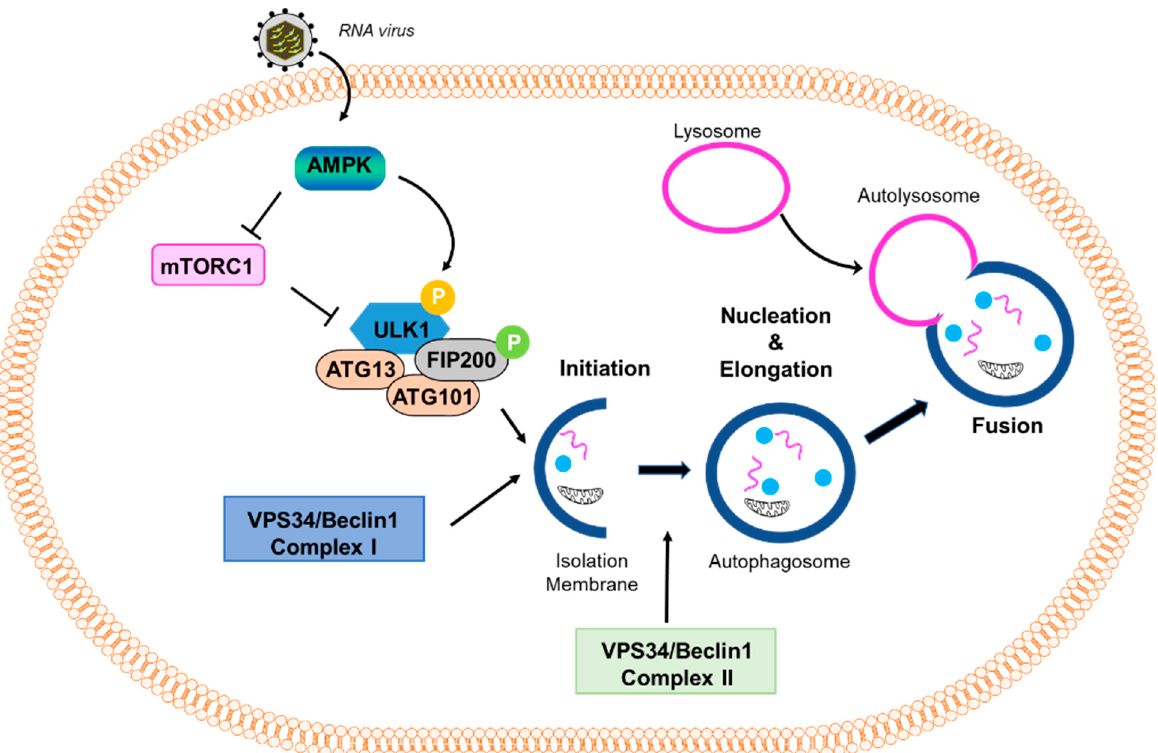
Figure 1. Virus-induced autophagy pathway. A scheme of the autophagy pathway: mTOR inhibits the autophagy pathway by negatively regulating the downstream effector protein ULK1 through phosphorylation. Stressful conditions, such as virus infection, activate AMPK, which inhibits mTOR and promotes the activation of ULK1. Activation of downstream effectors, such as ULK1 and VPS34/Beclin1 Complex I, induce the formation of an isolation membrane and initiate the formation and maturation of the autophagosome. VPS34/Beclin1 Complex II is important in the formation of the autophagosome. The autophagosome then fuses with the lysosome to form the autolysosome. Autophagy is induced when AMP-dependent kinase (AMPK) is activated in response as the inhibition of mTOR [13]. ULK1 functions in a complex with the additional proteins Fip200, Atg101, and Atg13. This complex leads to the activation of the PI3K complex, which comprises Beclin-1, Vps34, and Vps15. The activated PI3K complex converts PIP2 to phosphoinositide (WIPI) proteins, WIPI1 and WIPI2. The WIPI proteins play an